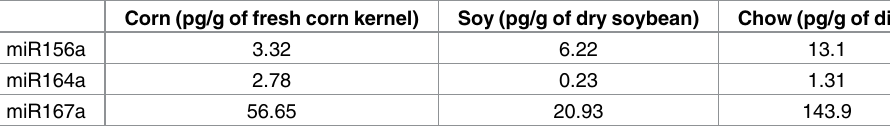
Table 3. miRNA concentration in corn and